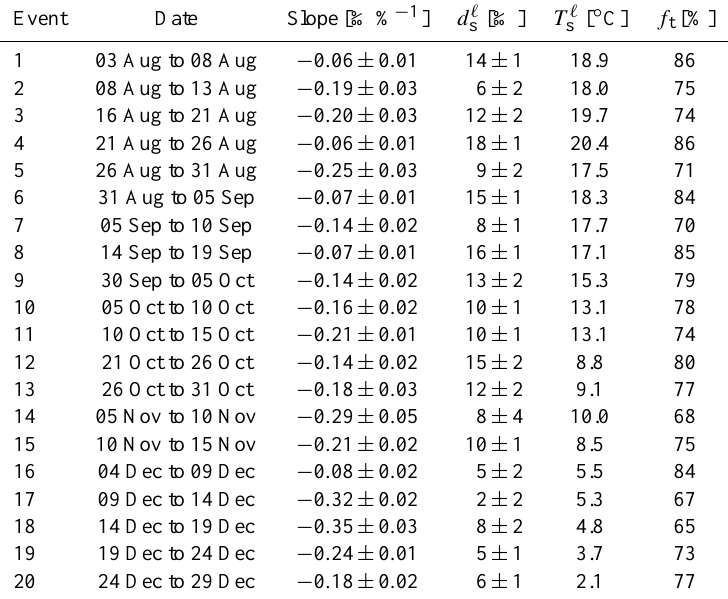
Table 6. Slope and intercept of d – h ‘ s relation for HLA events. The whole HLA data set is shown in Fig. 11 in a d – h ‘ s scatter plot. The columns show the date of the events, the slope, the diagnosed source d ‘ s (local soil moisture d signature) and the mean ground temperature. f t shows the transpiration fraction of the evapotranspiration flux at the Rietholzbach measurement site (see Sect. 7 for more details). The ocean contribution for HLA events is set to f o = 0 as the moisture source is assumed to be local. The statistical significance level for the slope obtained by linear regression was checked using a t test with a 98% confidence interval. The p value for the regressions of all the events is smaller than